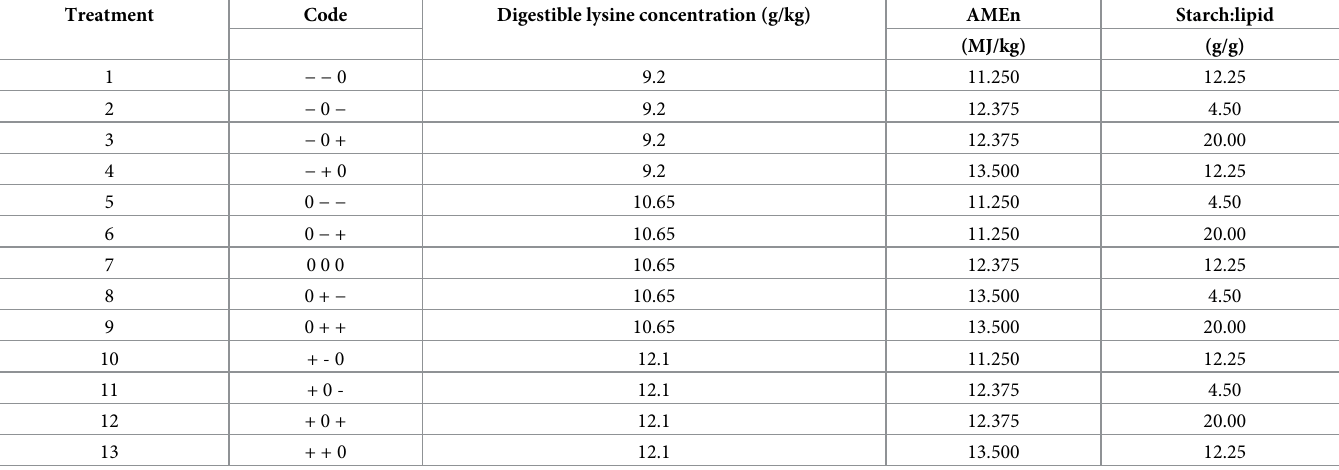
Table 2. The list of experimental treatments for broiler chickens from 21–35 days post-hatch.